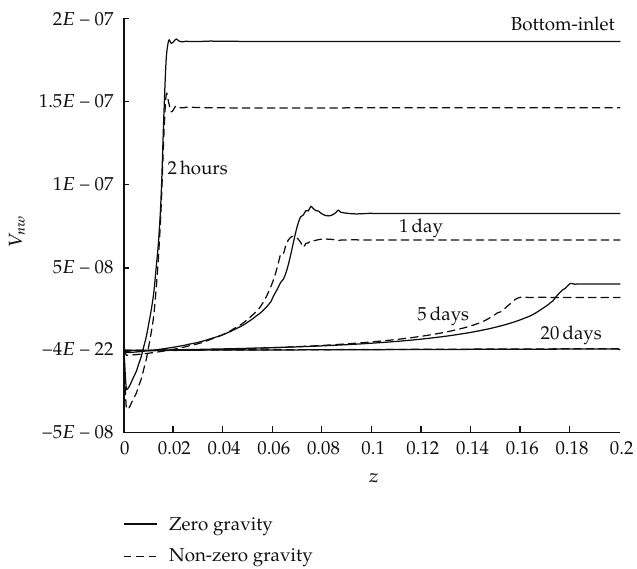
Figure 19: Comparison between considering and neglecting gravity e ff ect on oil z -velocity for the bottom- inlet case, at x (cid:8) 0 .